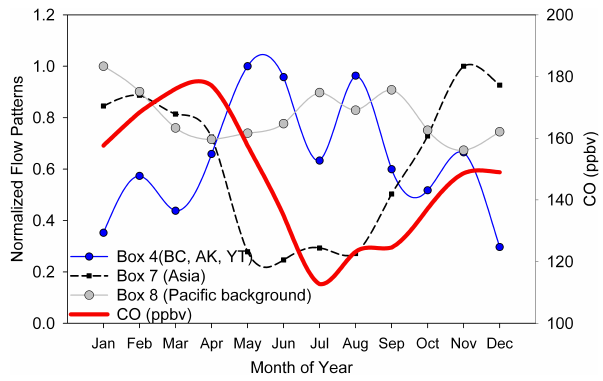
Fig. 6. Normalized frequency of transport through boxes defined in Fig. 5 as a function of month of year.